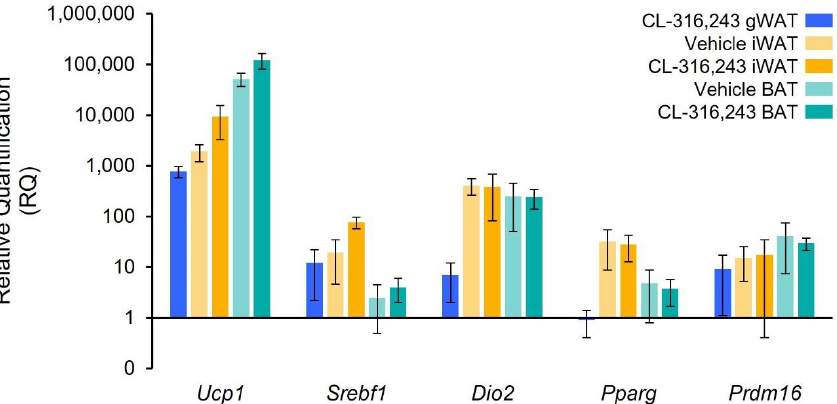
Figure 5. Relative quantification (RQ) of assayed genes. Values were normalized to mRNA expression in gWAT of vehicle mice. Data are reported as the mean expression value with 95% CI in vehicle ( n = 5) and CL-316,243 treated mice ( n = 4). RQ is shown on a logarithmic scale.